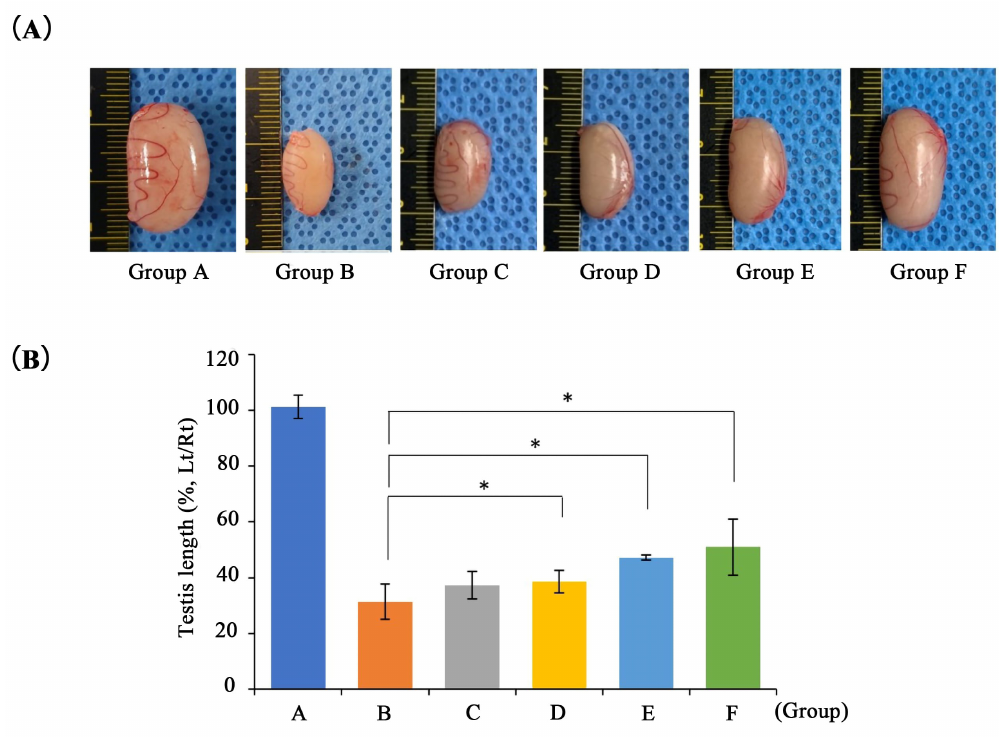
Fig. 2. Representative gross images of the extracted left testes (A) and comparison of the mean maximum longitudinal length ratios of the left and right testicles (B) in groups A to F (* p < 0.05). Group A: sham operation; Group B: torsion/detorsion (control group); Group C: torsion/detorsion with single administration of 0.3 mg/kg tadalafil; Group D: torsion/detorsion with daily administration of 0.3 mg/kg tadalafil for four weeks; Group E: torsion/detorsion with single administration of 1.0 mg/kg tadalafil; Group F: torsion/detorsion + daily administration of 0.3 mg/kg tadalafil for four